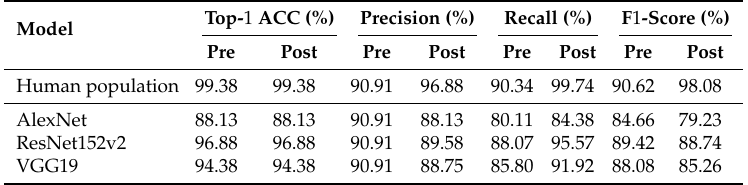
Table 4. Metrics of human subjects and the selected deep neural networks AlexNet [55], VGG19 [56], and ResNet152v2 [57] on the pre-CRT (original) and post-CRT (changed) ILSVRC2012 subset D (cid:48) .